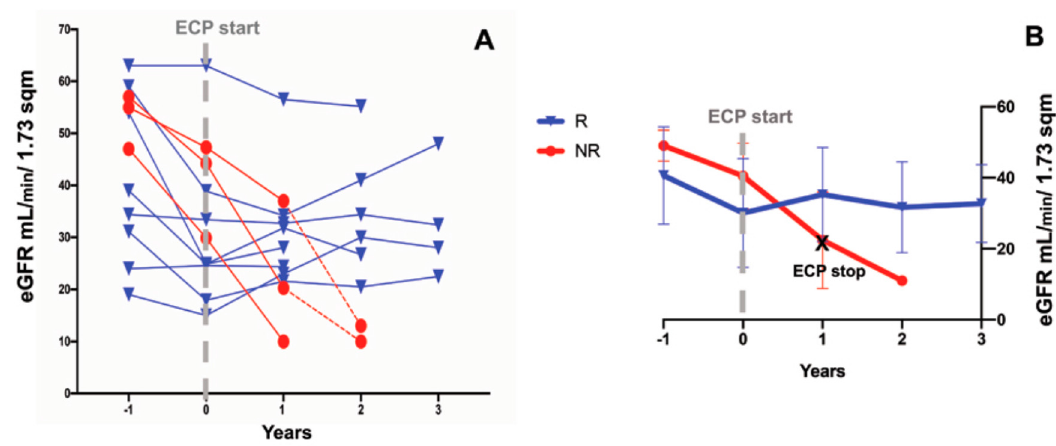
Figure 3. Renal function pre- and post-ECP treatment. Panel ( A ): The estimated glomerular filtration rate (eGFR was evaluated 1 year before and after the ECP treatment in responder (R) patients (blue line) and the non-responder (NR) patients (red line). In the R patients, the ECP treatment was prolonged by up to 3 years, showing the stabilization of the eGFR at the last follow up. In the NR patients, the follow up was prolonged after the discontinuation of the ECP for up to 1 year in two patients (spaghetti plot). The red dashed line marks the follow up after the ECP’s stoppage in the NR group. The dashed gray line indicates the start of the ECP treatment. Panel ( B ): The eGFR trend over time in the R (blue line) and NR (red line) patients. The dashed gray line indicates the start of the ECP. The black cross marks the end of the ECP treatment in the NR group. The data are expressed as the mean and SD.